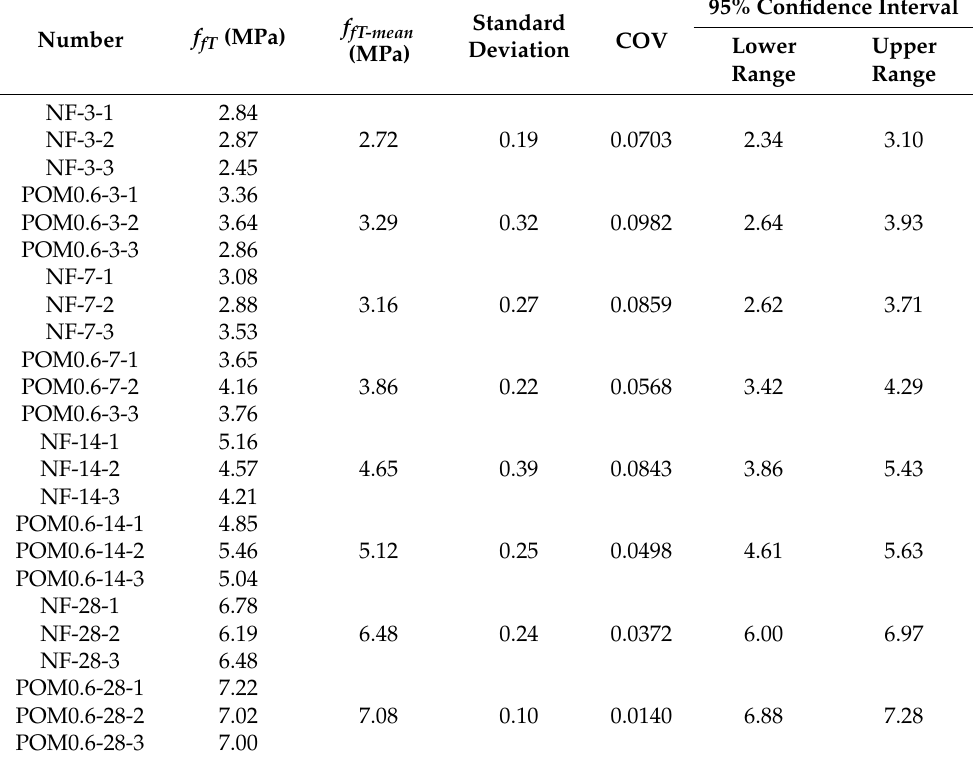
Table 8. Flexural strength of NF and POM0.6 specimens with different